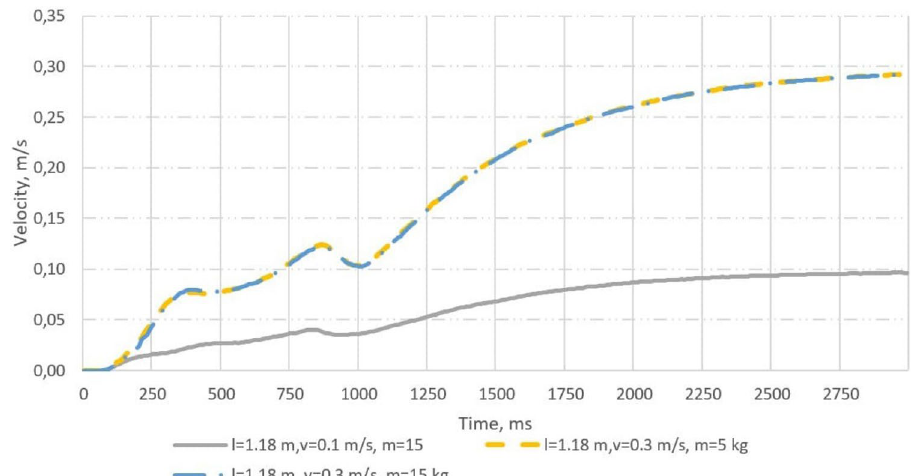
Fig. 8 Velocity of the crane